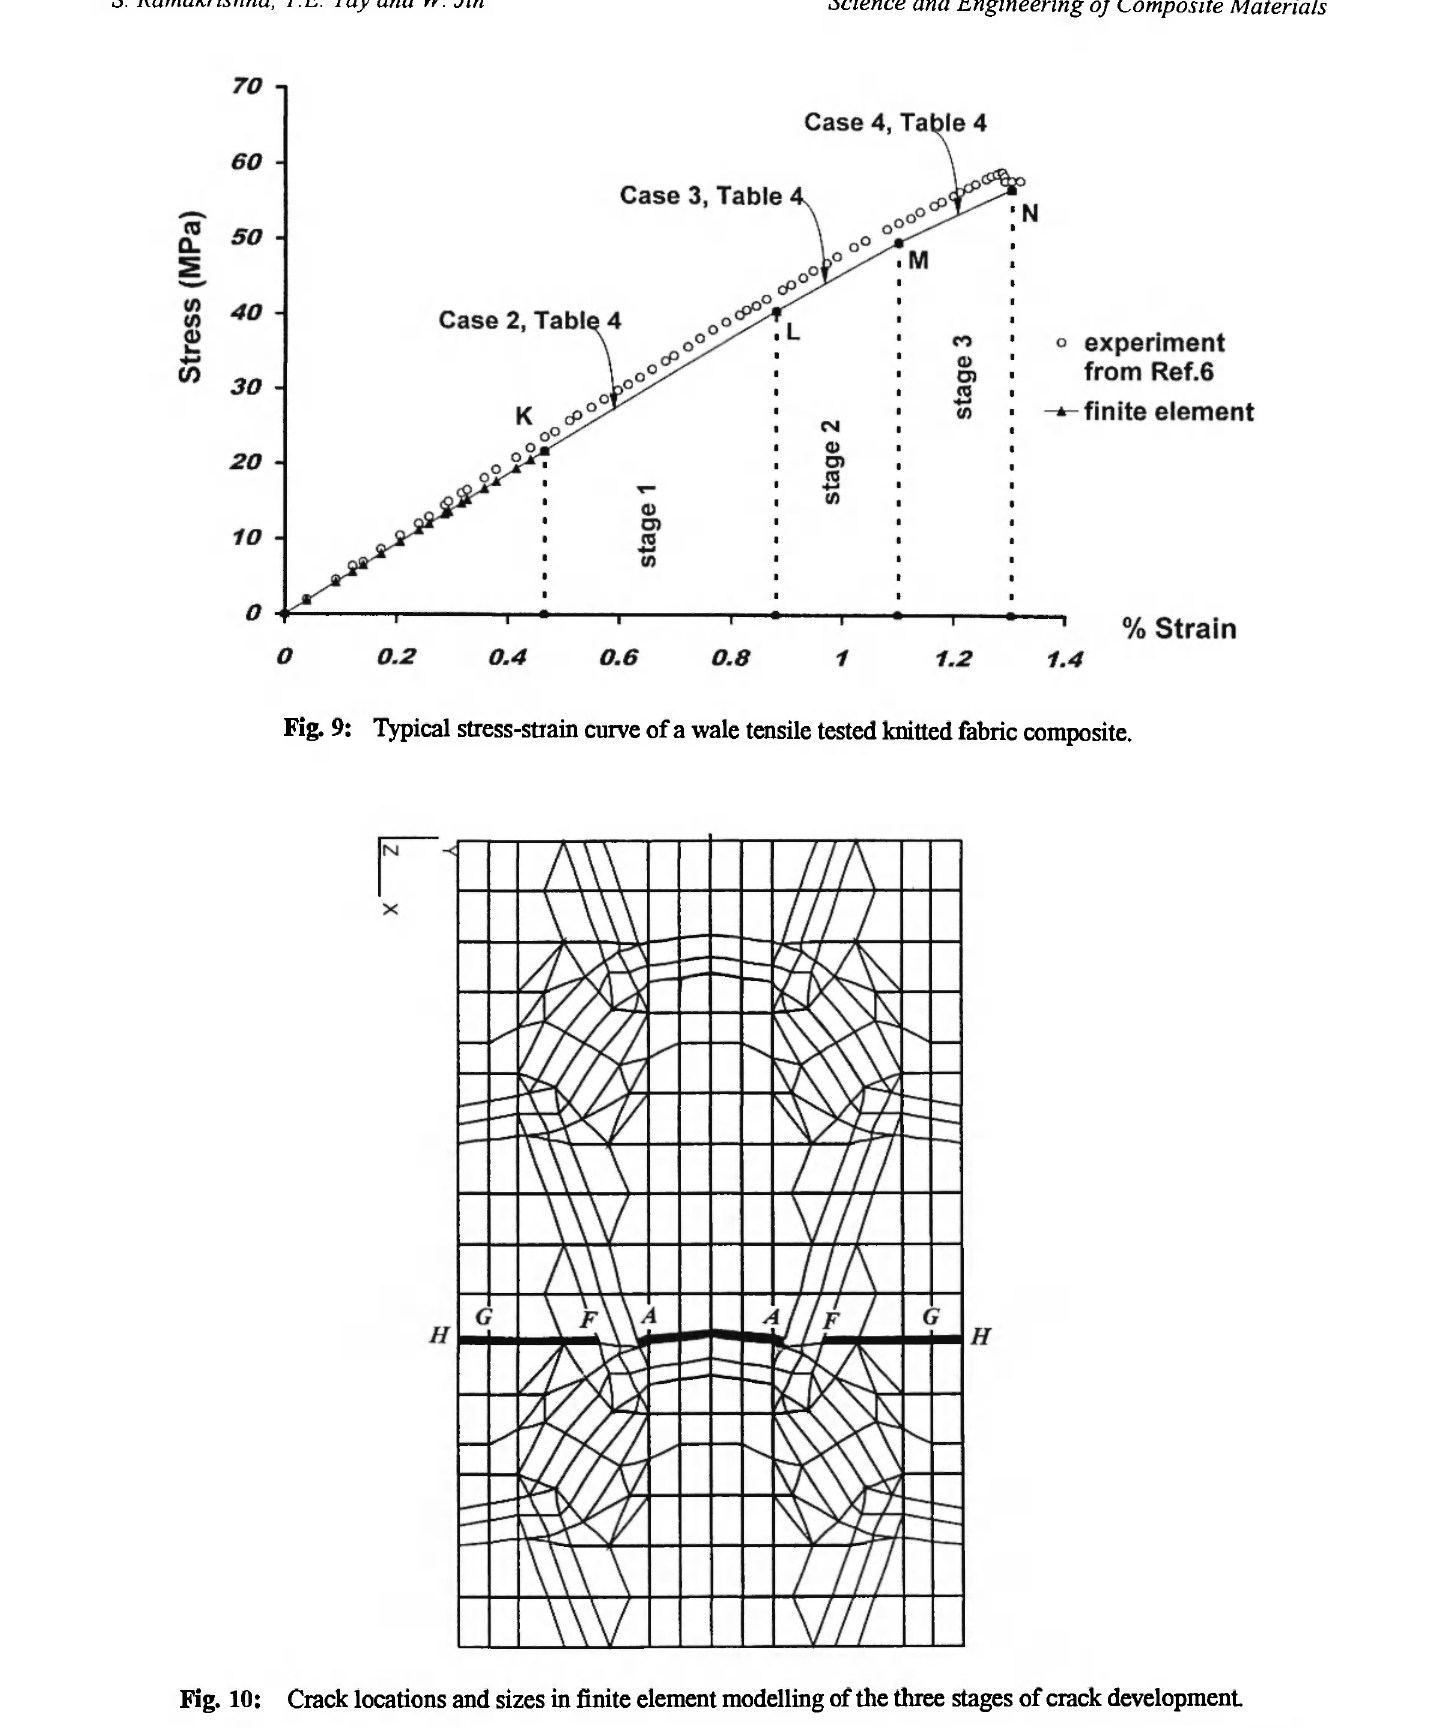
Fig. 10: Crack locations and sizes in finite element modelling of the three stages of crack